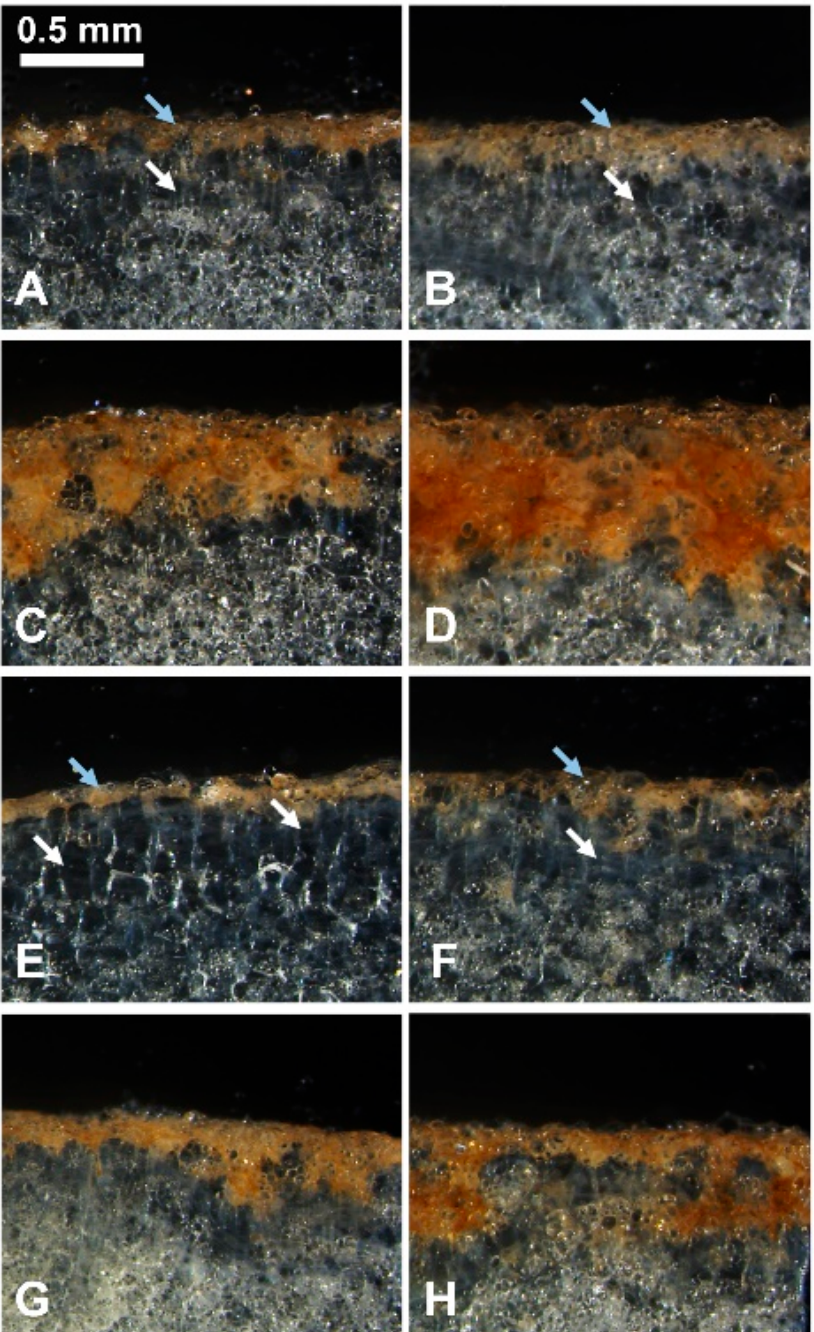
Figure 3. TA induces morphological changes in RB and YG tuber parenchyma. Photographs of sec- tions cut perpendicular to the TA-treated surface of RB ( A – D ) and YG ( E – H ) tuber slices, 7 days after treatment. ( A , E ) no treatment; ( B , F ) treated with MeOH; ( C , G ) treated with 5 µ M TA; ( D , H ) treated with 7 µ M TA. White arrows show the phellogen formation, blue arrows point to the closing